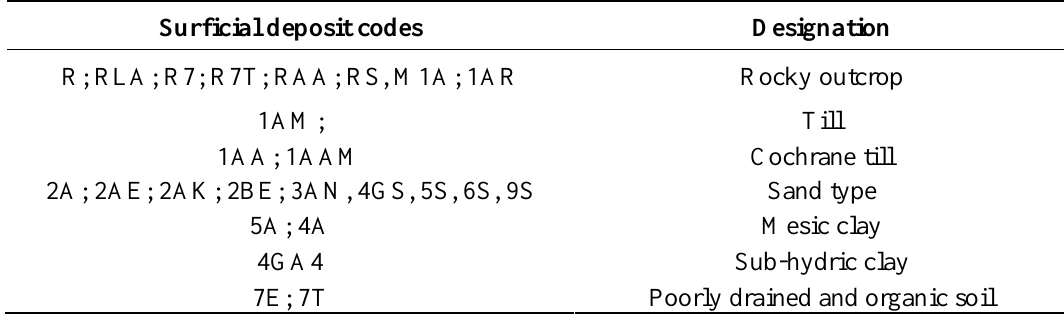
Table A2. Grouping of the surficial deposits based on SIFORT.